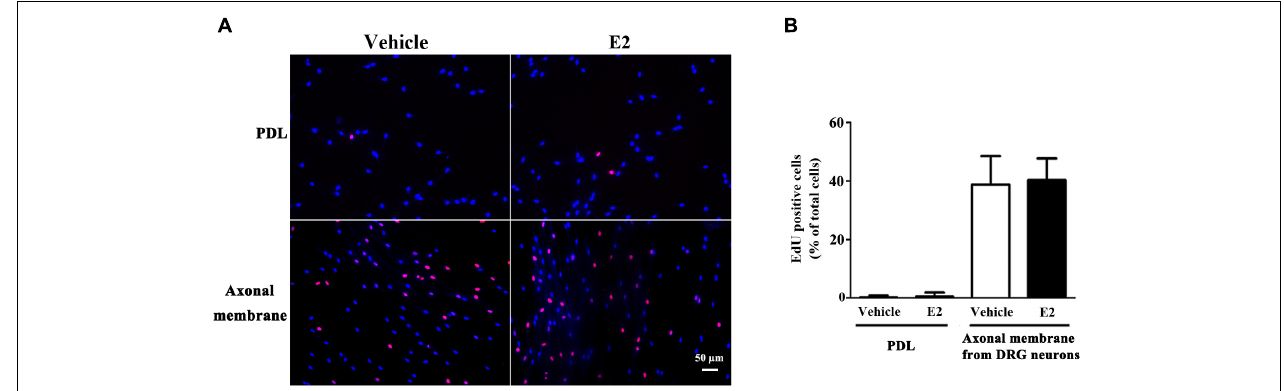
FIGURE 2 | Schwann cell proliferation was not modulated by E2. Schwann cells cultured on fasciculated DRG axons (axonal membrane) or PDL with or without E2 for 24 h, and the cell proliferation was measured by using EdU labeling. (A) The images of EdU staining (red) and Hoechst 33342 staining (blue) were used to measure cell proliferation, scale bar, 50 µ m. Cell counting was performed in at least 10 random microscopic fields (200 × magnification). (B) Histograms showing that there were no significant changes in cell proliferation of SCs between E2 treatment or not in cultured on fasciculated DRG axons or PDL. P > 0.05, Student’s t -test, n = 3 cultures per group. All the data are mean ±